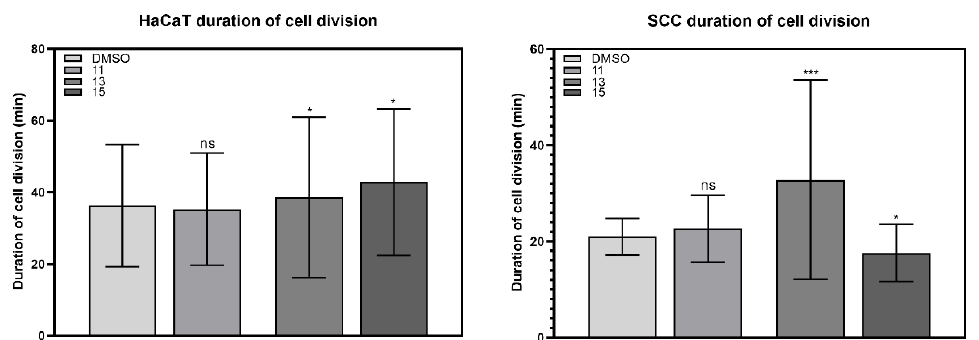
Figure 4. Effect of DMSO and compounds 11 , 13 and 15 on the duration of cell division of HaCaT and SCC cells. (Asterisks and “ns” refer to the levels of significance of the data based on the statistical significance test; ns: not significant ( p > 0.05), * p < 0.05; *** p < 0.001; p = probability level.)